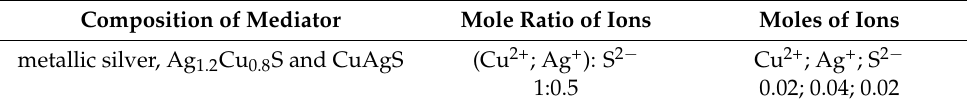
Table 2. Mole ratio of the copper, silver and sulfide ions. Composition of Mediator Mole Ratio of Ions Moles of Ions metallic silver, Ag 1.2 Cu 0.8 S and